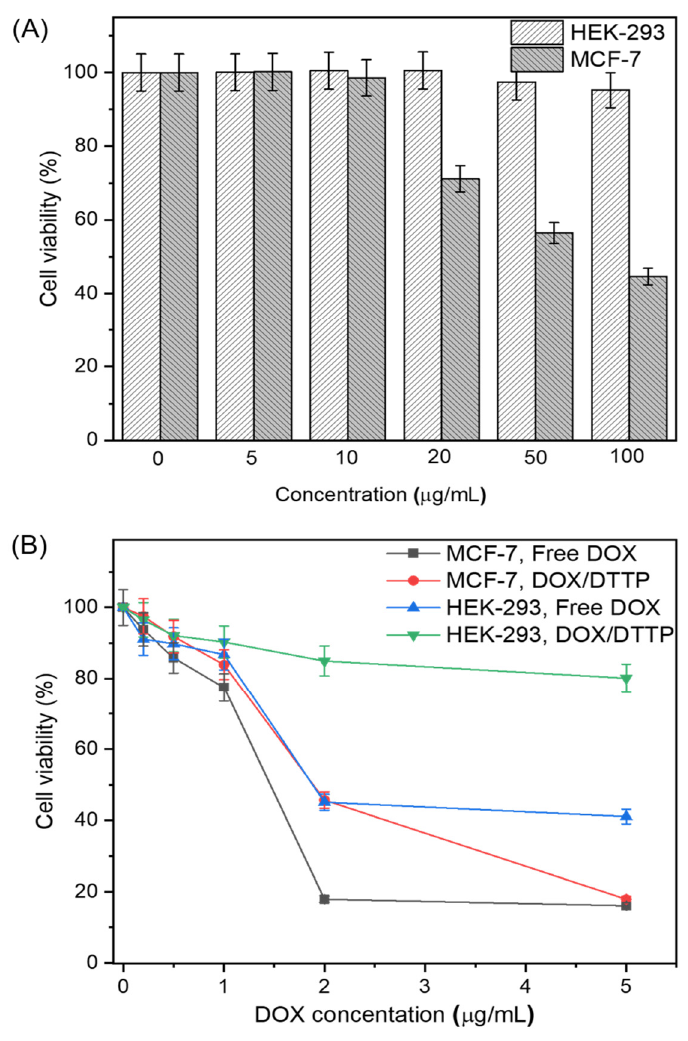
Figure 6. HEK-293 normal and MCF-7 cancer cell viability after incubation with different DTTP micelle concentrations for 24 h ( A ). HEK-293 and MCF-7 cell viability determined by CCK-8 assay after incubation with various concentrations of free DOX and DOX-loaded micelles for 24 h ( B ). Means ± S.D. of five independent experiments.